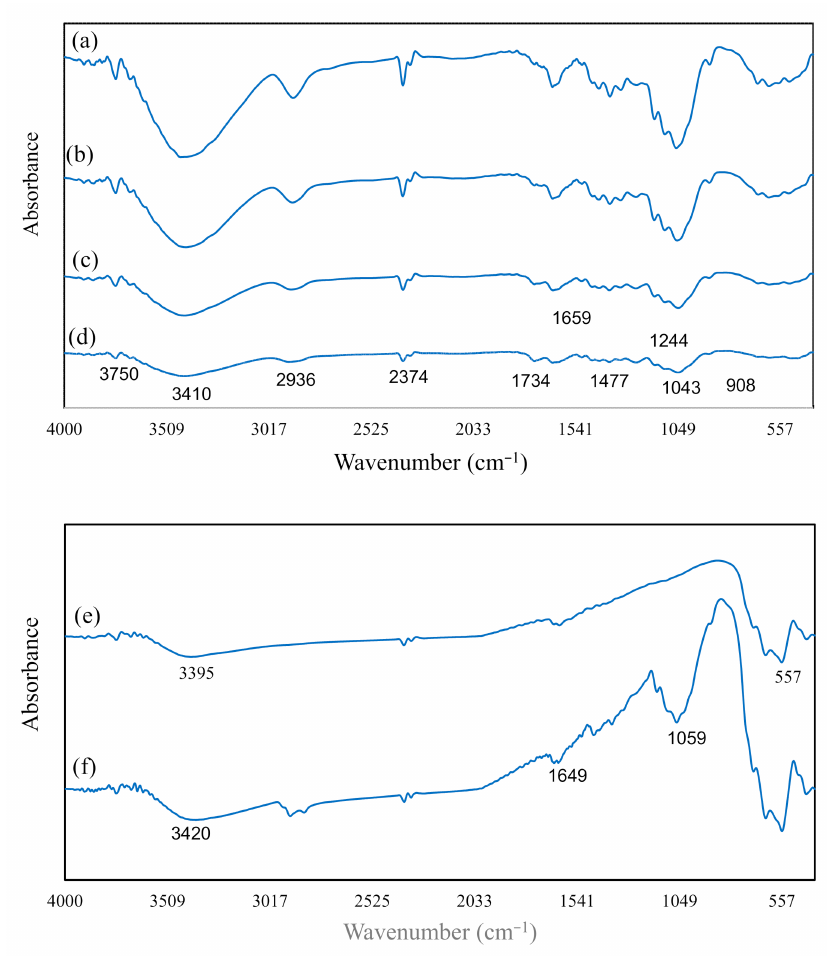
Figure 6. FT-IR spectra of ( a ) Raw OPEFB fiber, ( b ) pulped OPEFB fiber, ( c ) bleached-pulped OPEFB fiber, ( d ) CNF, ( e ) Fe 3 O 4 , ( f )